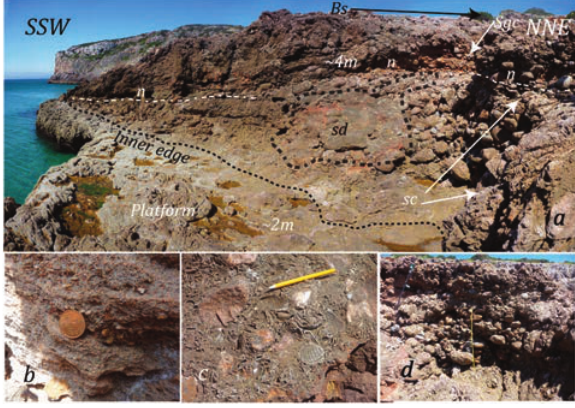
Figure 5. Marine terrace at Furnas site. Location is given in Figure 2. a) Perspective of the terrace: An abrasion platform and an inner edge are recognized at ~2 m elevation; a notch level (~4 m elevation) and sea cave (between ~4 and ~2 m elevation)are also indicated; A small surge channel (Sgc) is identified, suggesting that the sand deposit (sd) that covers the coarser deposits is correlated with the beach sand de- posit (Bs) present at ~8 m elevation. b) detail of beach sand unit; c) detail of sand deposit; d) sea cave filled by coarse